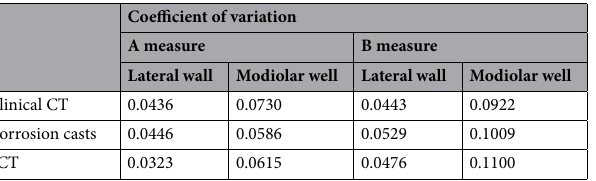
Table 1. Coefficients of variations are consistently larger for modiolar measures compared to the lateral wall